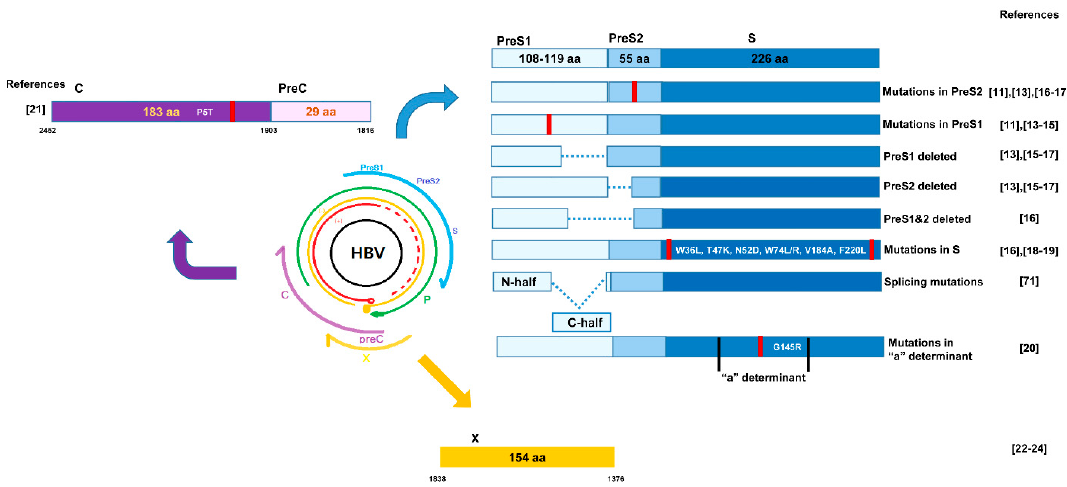
Figure 1. Locations and types of hepatitis B virus (HBV) mutations reported to induce endoplasmic reticulum (ER) stress in previous literature. Mutations in preS1 ([11,13–15]), and PreS2 ([11,13,16,17]) deletion in PreS1 and preS2 ([13,15–17]), or deletion in both region ([16]) are indicated. Several mutations in S regions are reported ([16,18,19]) including those in "a" determinant ([20]). Mutations in core ([21]) and X region ([22–24]) reported to cause ER stress are